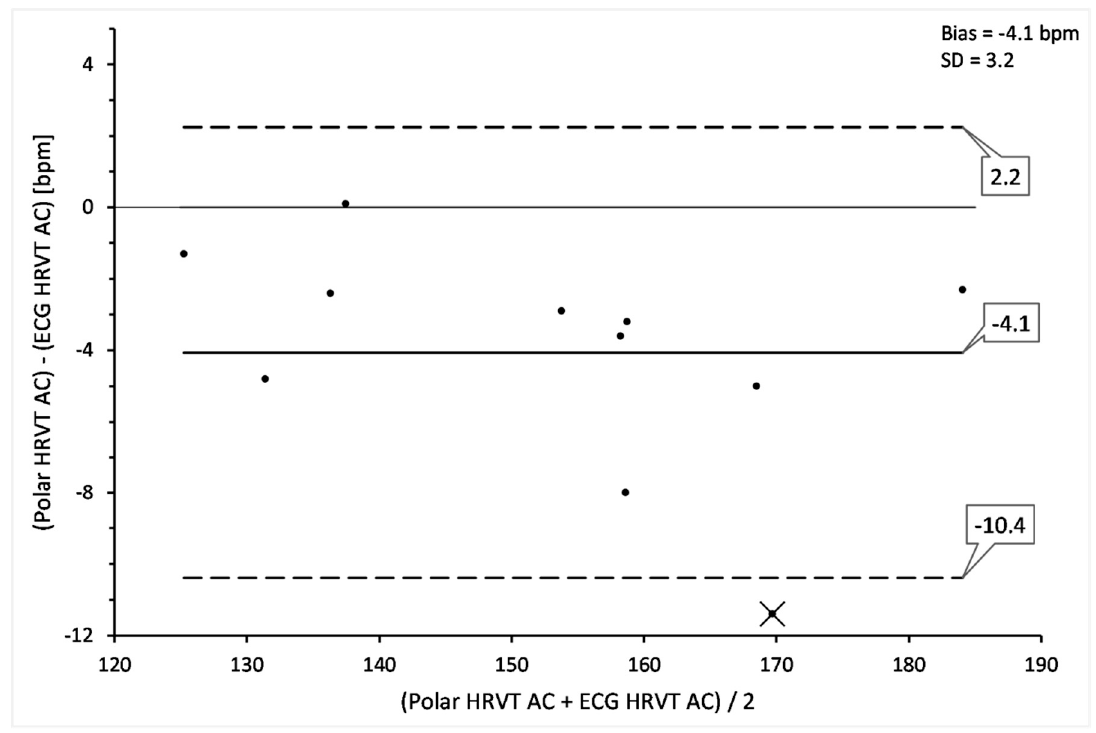
Figure 5. Comparison of heart rate at HRVT between ECG vs. Polar H7 data using Bland Altman analysis. The one outlier (labeled as X) represents the only participant with no artefact in both ECG and Polar H7 time series. Center line represents the mean bias (difference) between each paired value. The top and bottom lines are 1.96 standard deviation from the mean difference. Bias and standard deviation (SD) listed in upper right corner.